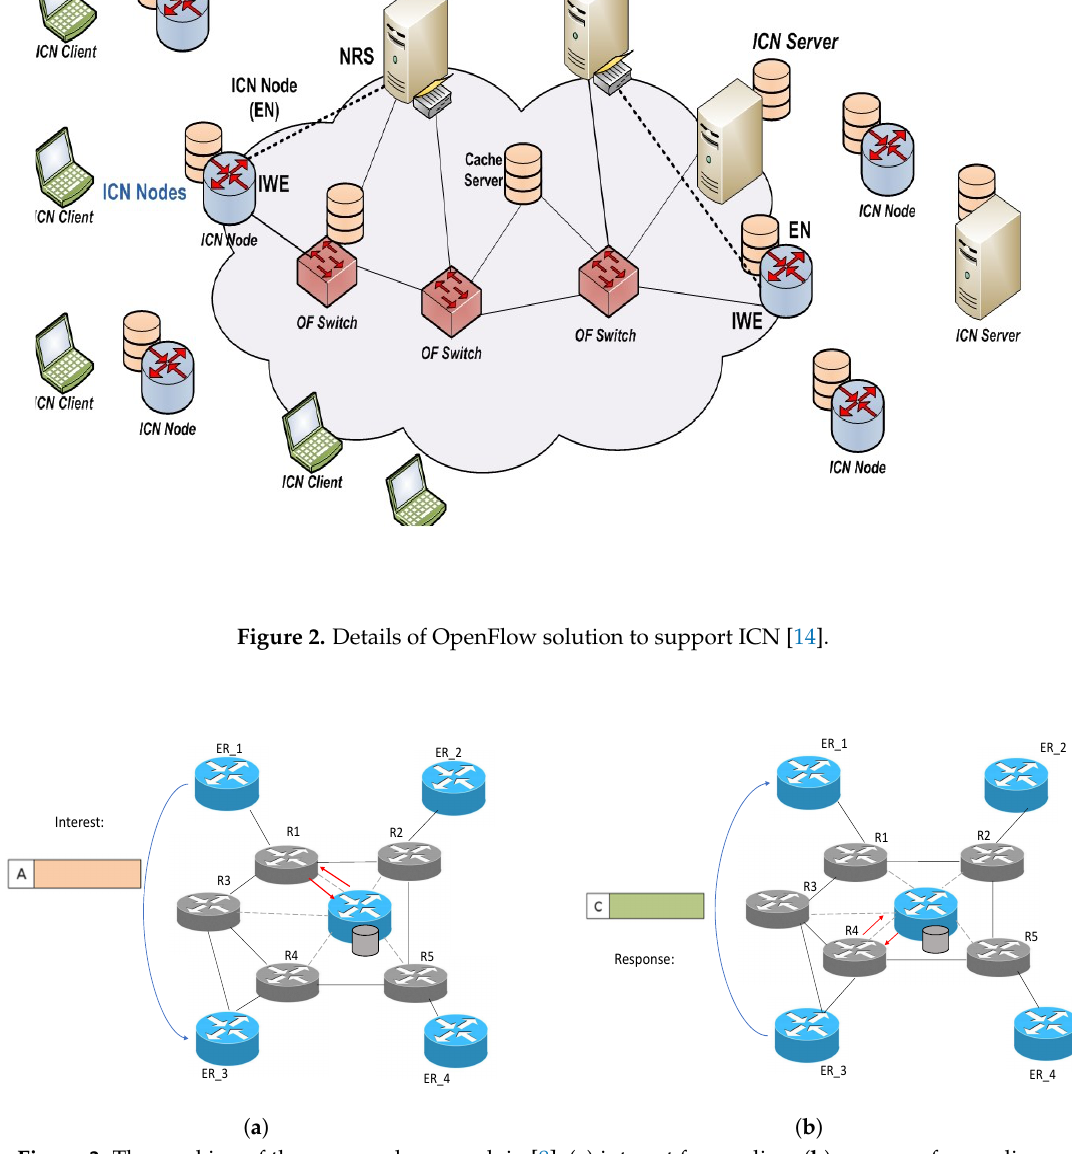
Figure 3. The working of the proposed approach in [8]; ( a ) interest forwarding; ( b ) response forwarding. Table 1. The comparison of existing approaches for SDN-based